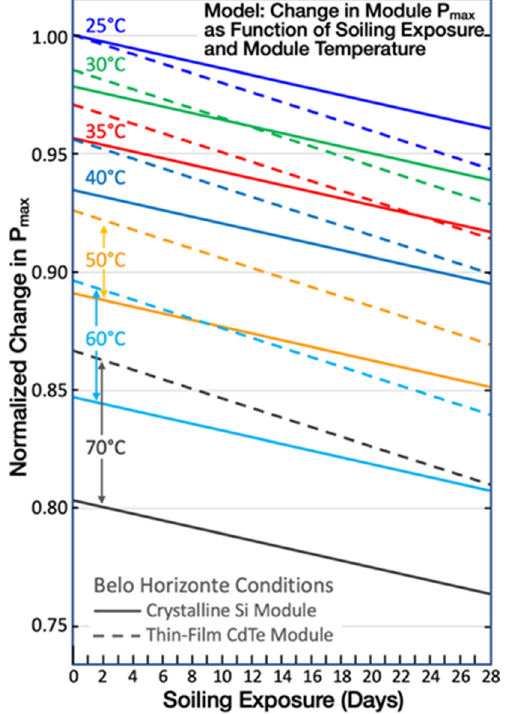
Figure 3. Modeling of normalized change in P max as function of soiling exposure days for various module temperatures, comparing Si with thin-film CdTe module. The crossover point (days) for each temperature pair (solid line for Si and dashed line for CdTe) indicates the predicted point at which the spectral absorption begins to dominate the module operating temperature.